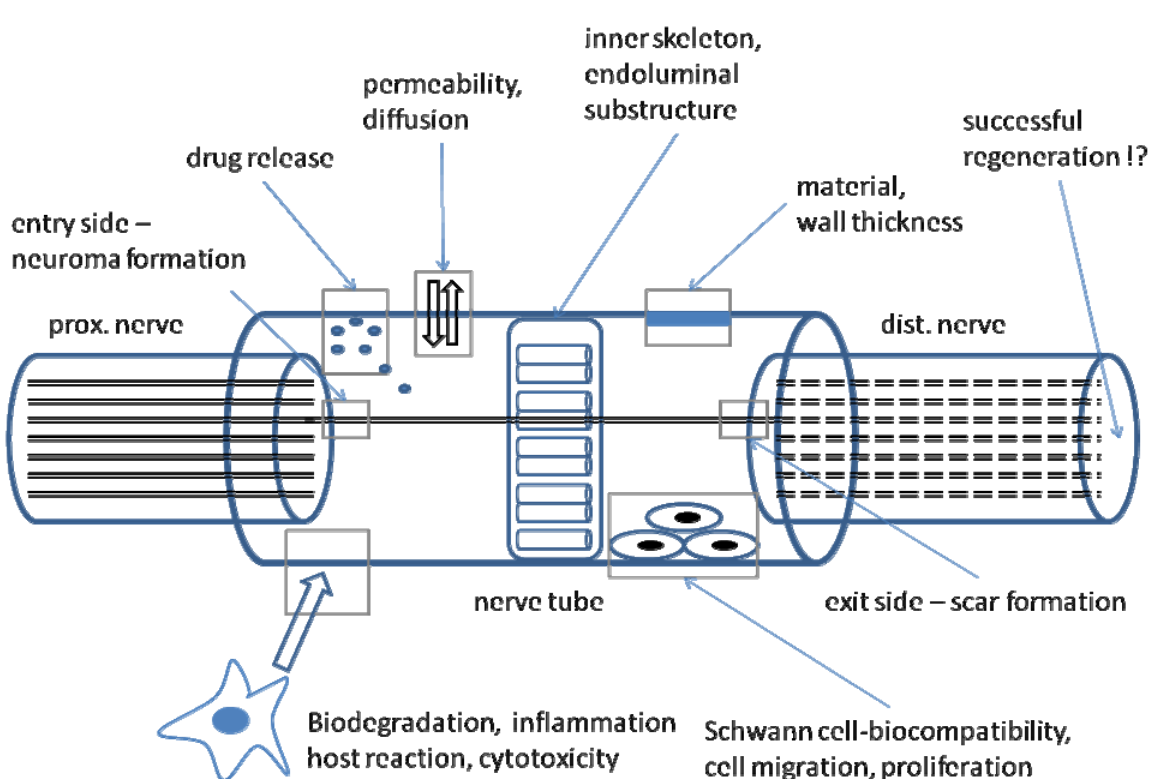
Figure 2. Different aspects of an artificial nerve